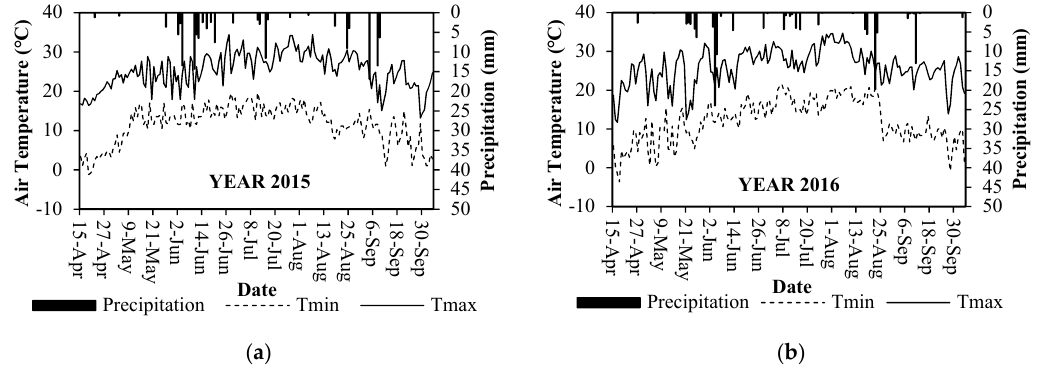
Figure 1. Daily meteorological data during the crop growth period for 2015 and 2016: ( a ) daily meteorological data for 2015; ( b ) daily meteorological data for 2016.